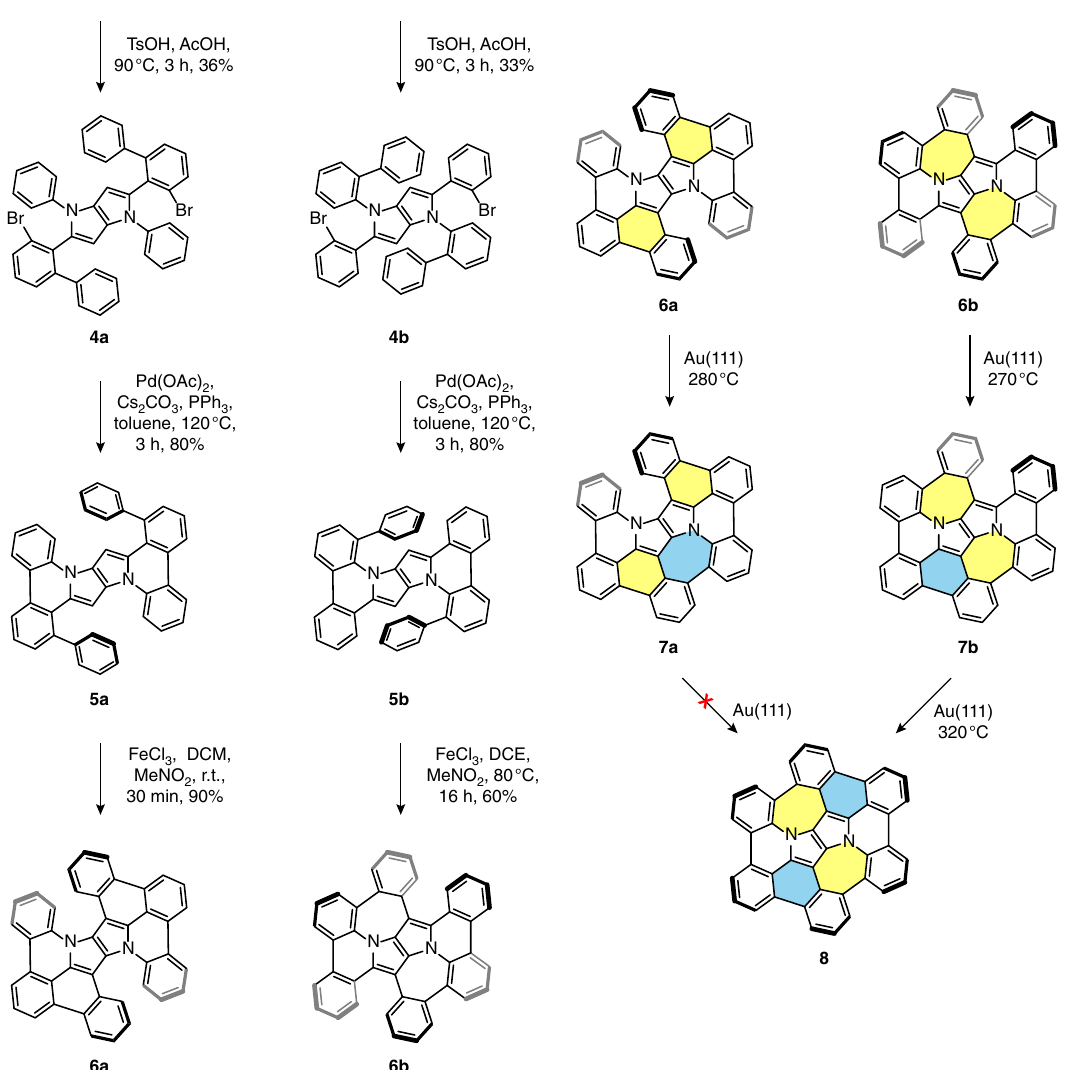
Fig. 1 Synthetic route to the nitrogen-embedded buckybowl 8 . (Left panel) Solution-synthetic routes to precursor molecules 6a and 6b . (Right panel) Subsequent on-surface synthetic route to partially closed species 7a , 7b and the fully conjugated nitrogen-embedded buckybowl 8 . Crucial rings formed in the fi nal steps are marked in colors (via oxidative aromatic coupling — yellow, via on-surface cyclodehydrogenation —